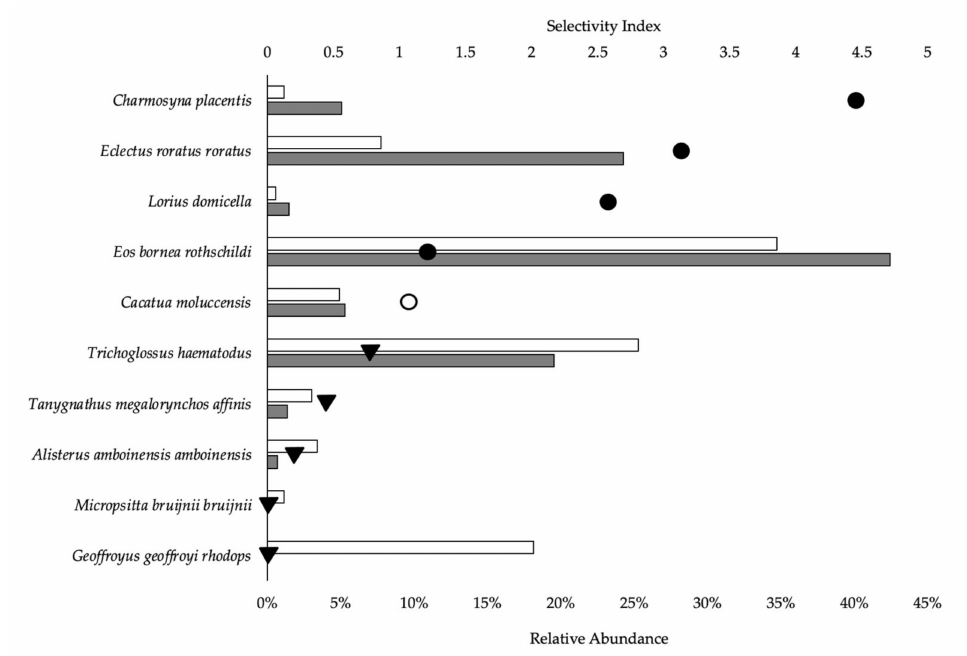
Figure 3. Relative abundance of parrot species in Seram, Indonesia as confiscated from the trade (dark gray bars) and observed in the wild (white bars), and selectivity index (W; black dots: significant positive selection; black triangles: significant negative selection; white dot: non-significant